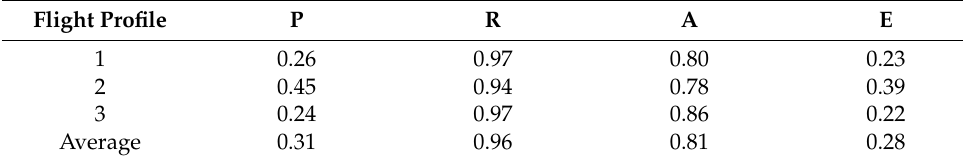
Table 3. URREF Metrics over Sample Videos (E could be